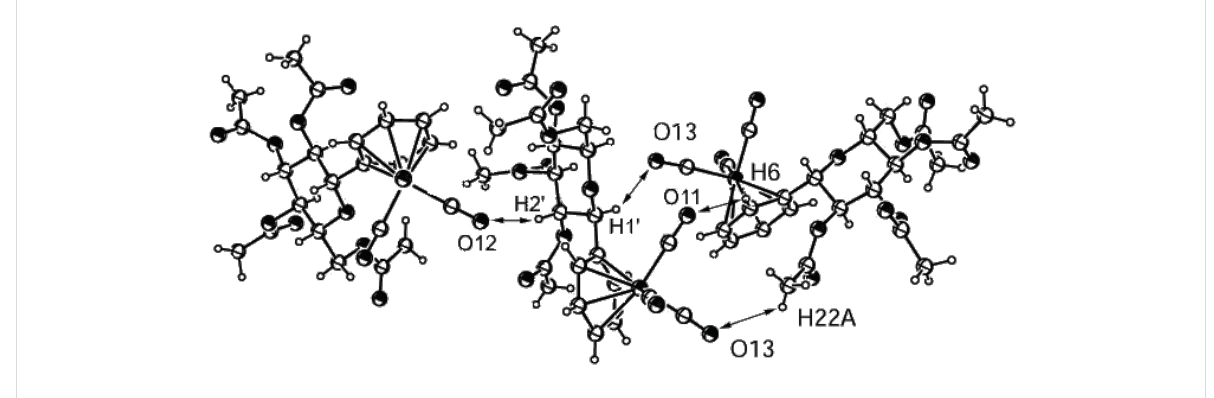
Figure 8: ORTEP-plot of the asymmetric unit showing three molecules of compound 2k and 30% probability ellipsoids; the arrows show the nonclas- sical H-bonds between O12 and H2’, O13 and H1’, O11 and H6 and O13 and H22A.